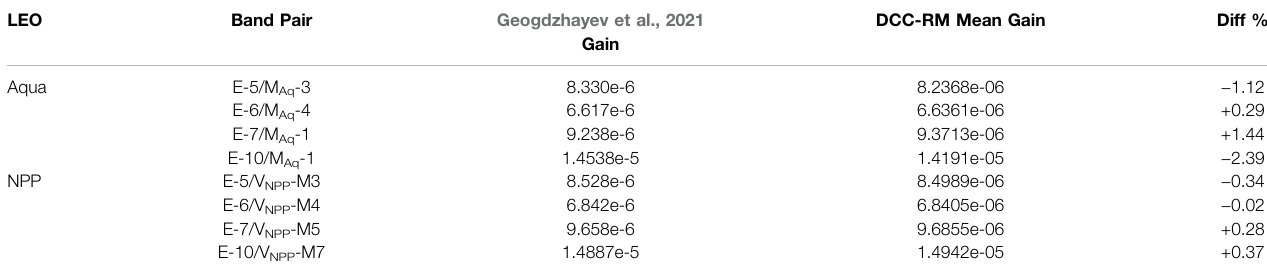
TABLE 4 | The EPIC V03 channel DCC-RM and the Geogdzhayev et al., 2021 mean gain for the record ending in June 2019 before the safe mode incident. The DCC-RM method drift-corrected the Aqua and NPP channel re fl ectances, while Geogdzhayev et al., 2021 combined the Terra and Aqua MODIS re fl ectances to compute the MODIS based gains. Note that Geogdzhayev et al., 2021 used E-10/M Aq -2 while this study uses E-10/M Aq -1. LEO Band